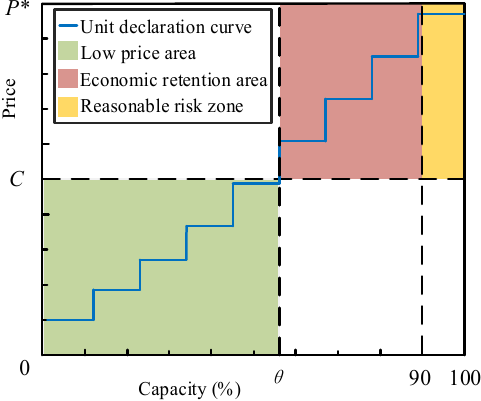
Figure 2. Diagram of the price declaration interval for generators.